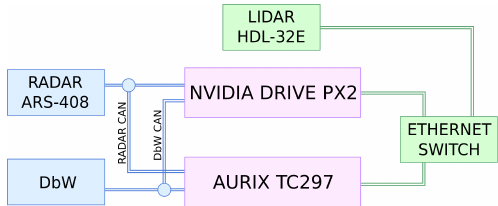
Figure 6. Simplified safety architecture diagram.